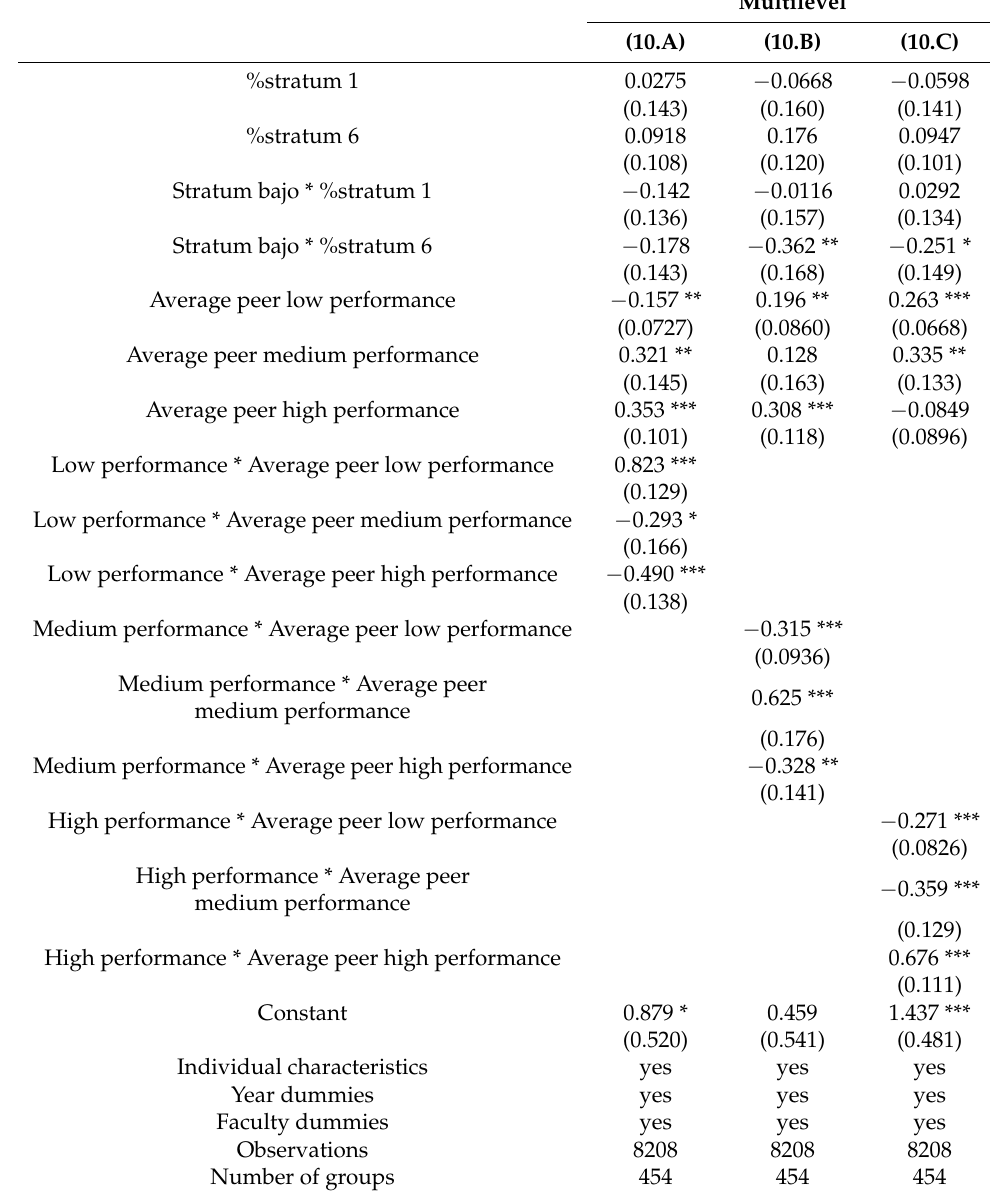
Table A5. Effects of heterogeneous peers according to student’s academic performance in Calculus I.